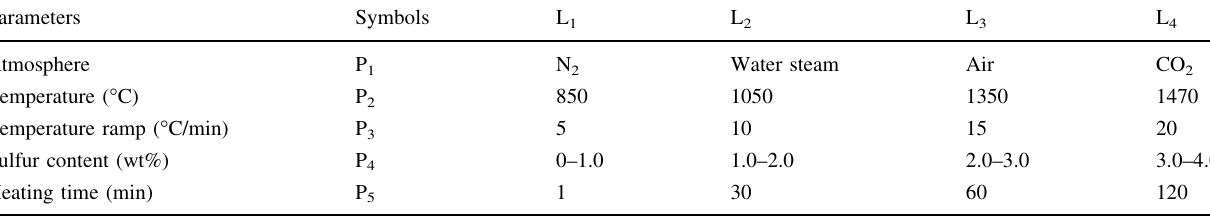
Table 1 The controlled parameters in L 16 orthogonal-array at different levels